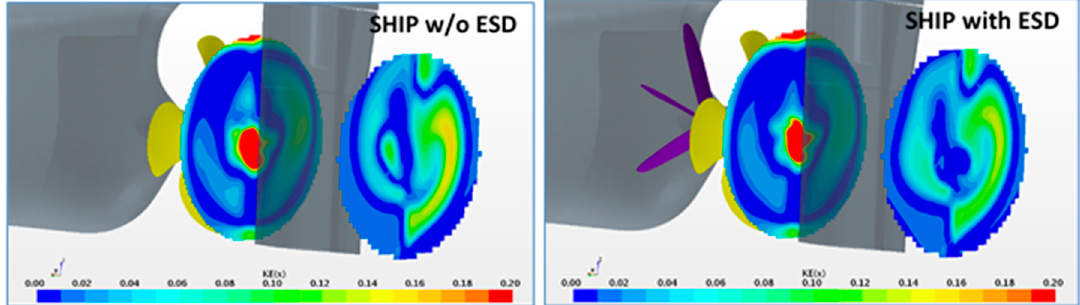
Figure 10. Distribution of the kinetic energy of transverse flow on sections “Sect 2” and “Sect 3” downstream of the propeller (PSS-Var-5, full scale, Vs = 14 kn).